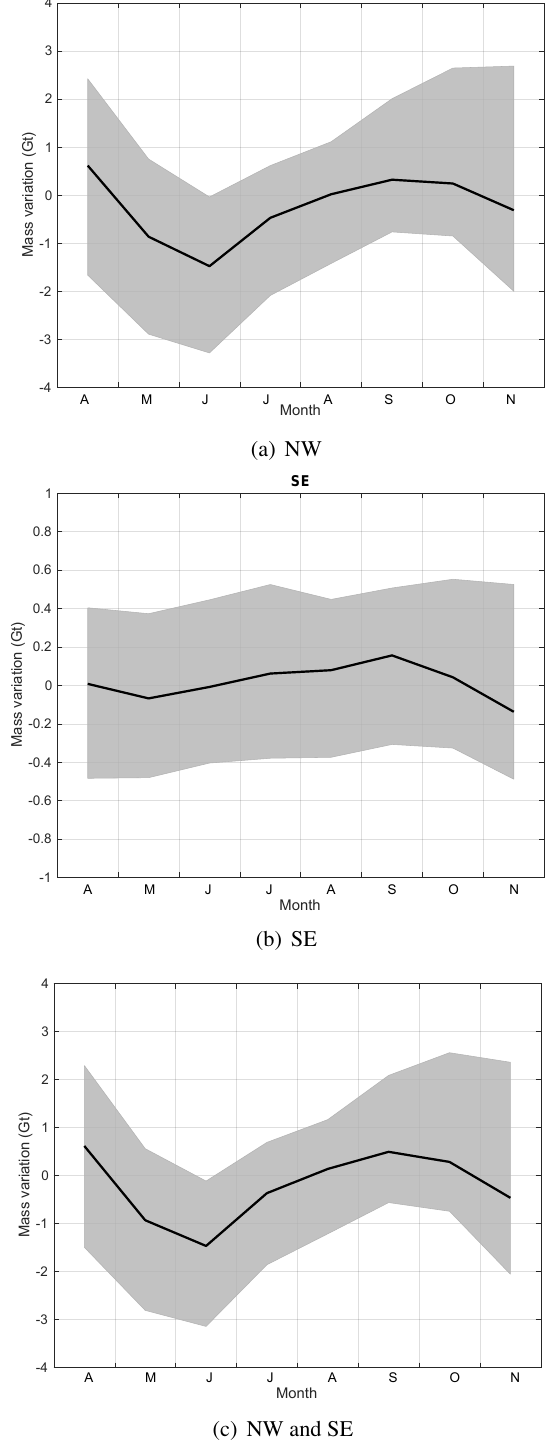
Figure 8. Similar to Fig. 6 but for mean ice-discharge-related vari- ations over 2009–2013. The cumulative mass anomalies are com- puted from glaciers in NW (a) and SE (b) drainage systems indi- vidually, and for glaciers in NW and SE together (c)